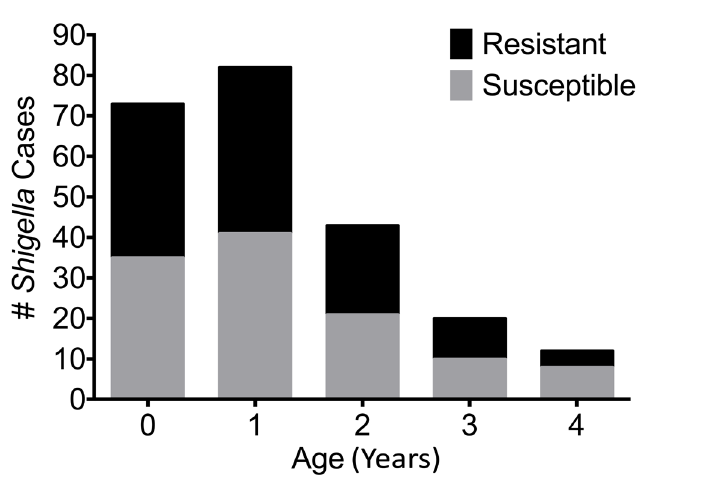
Figure 1. Shigella susceptibility by